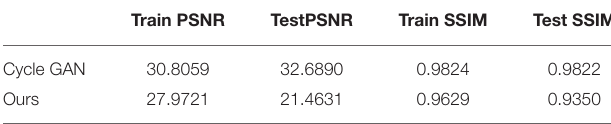
TABLE 6 | Quantitative results of CycleGAN and the proposed GFRSNs with fractional orders α 1 = 0.4, α 2 = 1 on the CelebA